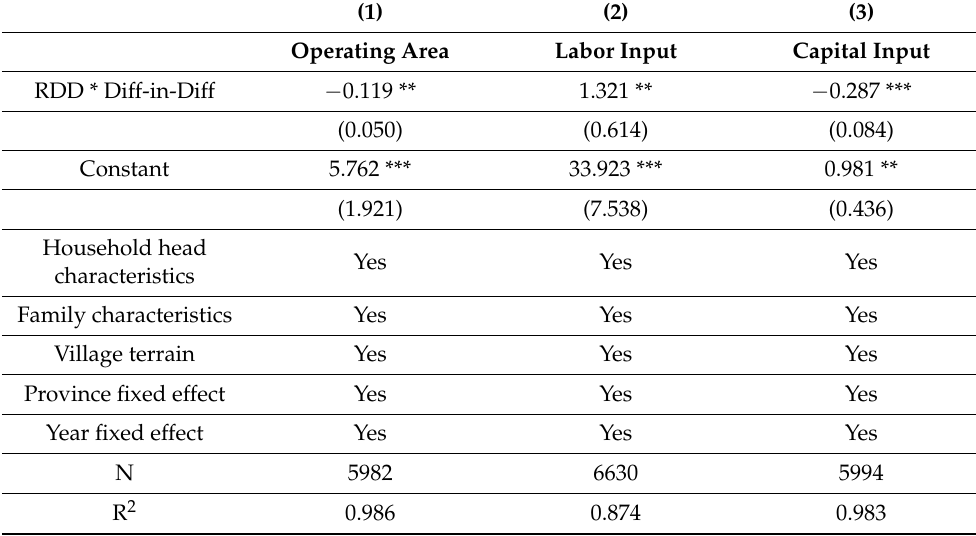
Table 5. Robustness test: Adjusting the estimation